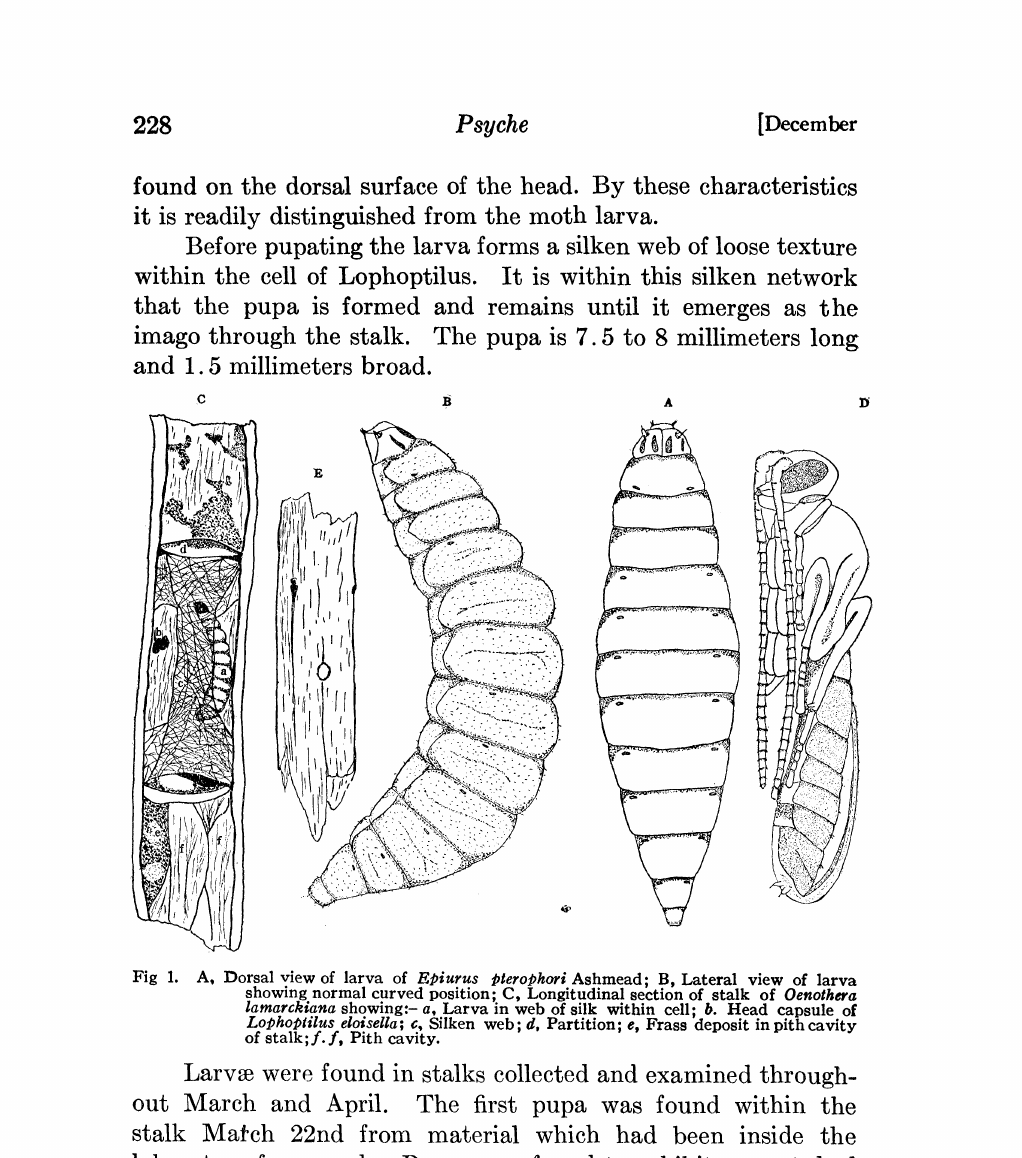
Fig 1. A, Dorsal view of larva of tpiurus pterophori Ashmead; B, Lateral view of larva showing normal curved position; C, Longitudinal section of stalk of Oenothera , lamarckiana showing:-a, Larva in web of silk within cell; b. Head capsule of Frass deposit in pith cavity Lophoptilus eloisella; c, Silken web; d, Partition; of stalk; f. f, Pith